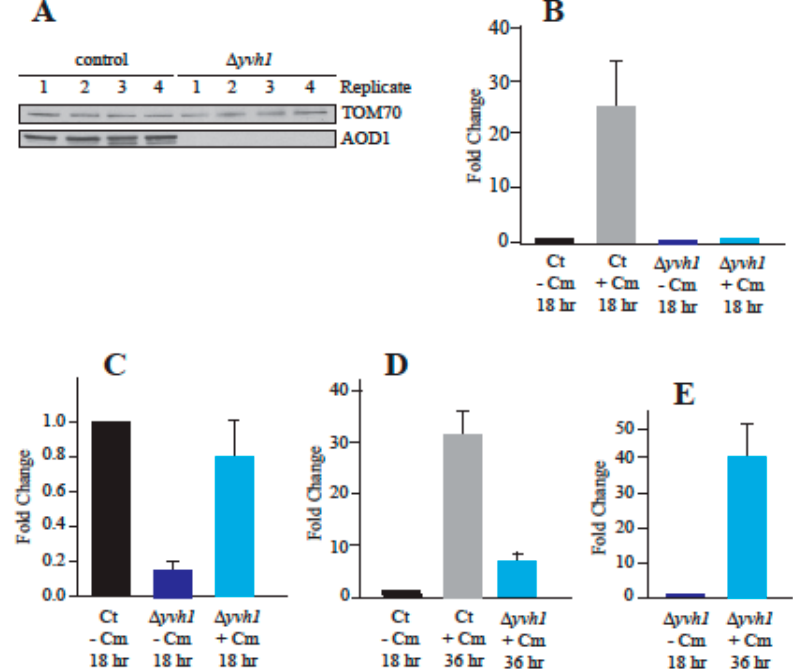
Figure 2. Levels of aod-1 transcript in ∆ yvh1 . ( A ) Western blot analysis of biological replicates of the control strain (NCN251) and ∆ yvh1 grown in the presence of Cm for 18 hr. This was done as a control to insure that the 18 h mutant samples contained little to no detectable AOD1 protein prior to qPCR analysis. Mitochondria were isolated from the replicates and mitochondrial proteins were separated by SDS-PAGE, blotted to nitrocellulose membrane, and probed with the antibodies indicated on the right. RNA was also isolated from each replicate for use in qPCR analysis. ( B – E ) qPCR of aod-1 transcript levels in control (Ct, NCN251) and ∆ yvh1 grown in the presence or absence of the inducer Cm ( + Cm or − Cm) for 18 h or 36 h as indicated. In each panel the fold increase or decrease is shown relative to the first data set in that panel. Black bars indicate the control strain grown in the absence of Cm while grey bars indicate the control grown in the presence of Cm. Dark blue bars show the ∆ yvh1 mutant grown in the absence of Cm and light blue bars indicate the mutant grown in the presence of Cm. Error bars represent 95% confidence intervals. Fold change values were relative to the control (NCN251) grown in the absence of Cm for 18 h ( B – D ) or ∆ yvh1 grown in the absence of Cm for 18 h ( E ). Samples were normalized to GAPDH based on the ∆∆ CT-method.